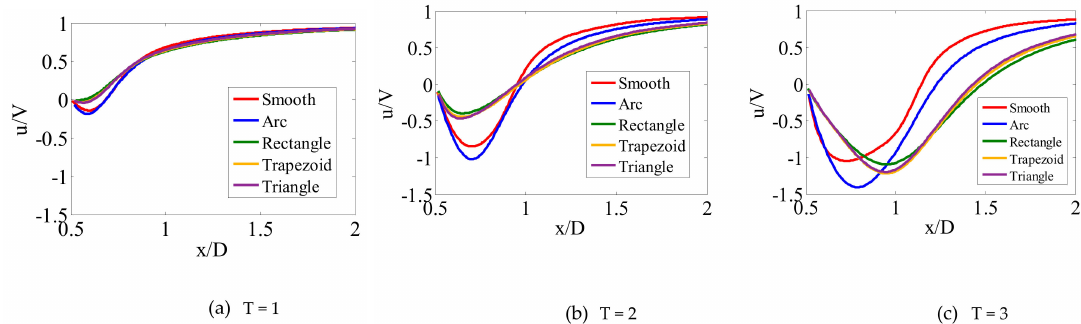
Figure 16. The comparison of the velocity distribution at di ff erent moments on the axis between the smooth cylinder and cylinder with strips of di ff erent shapes for Re =